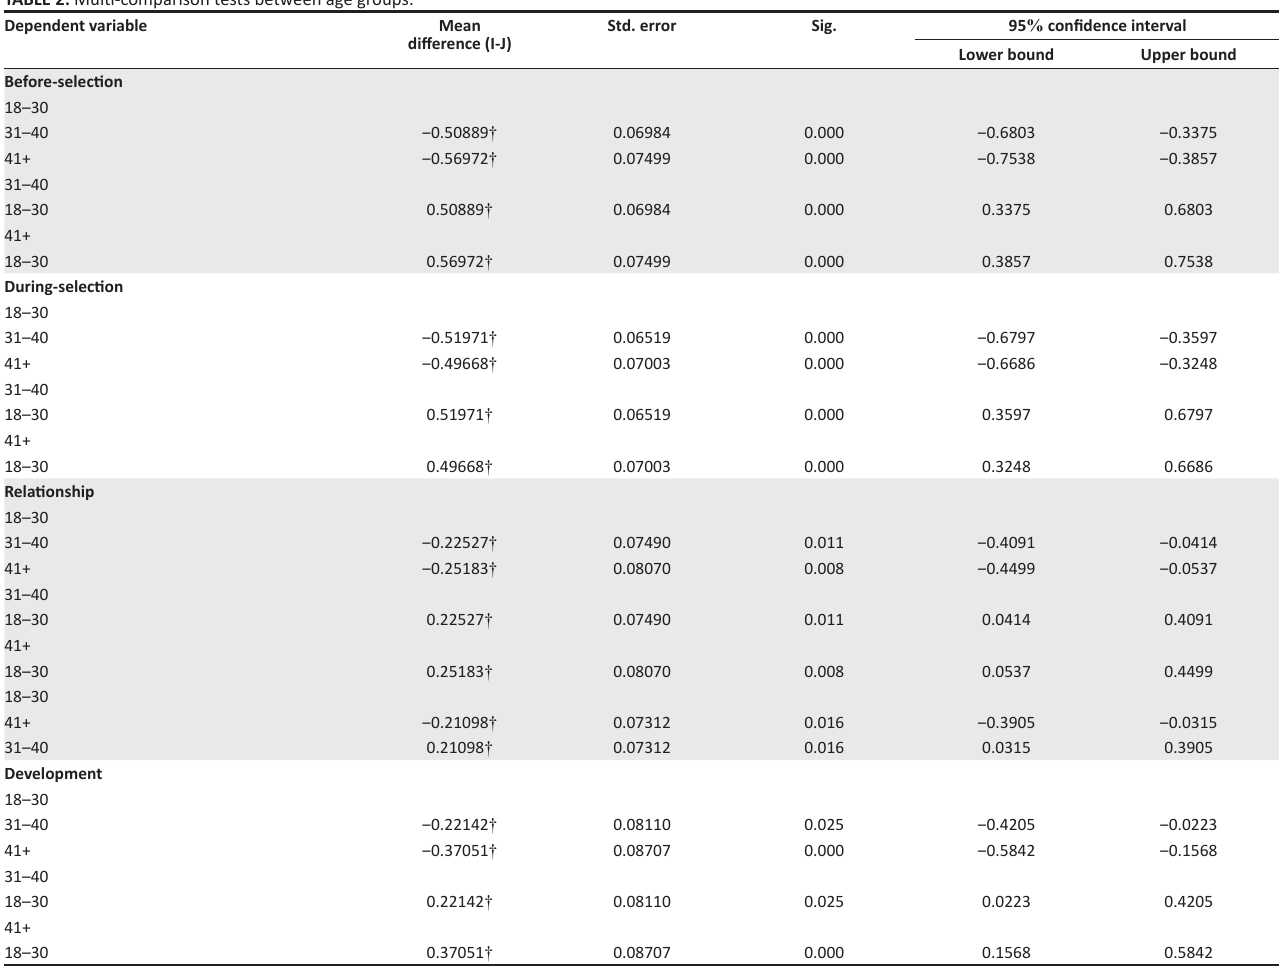
TABLE 2: Multi-comparison tests between age groups.